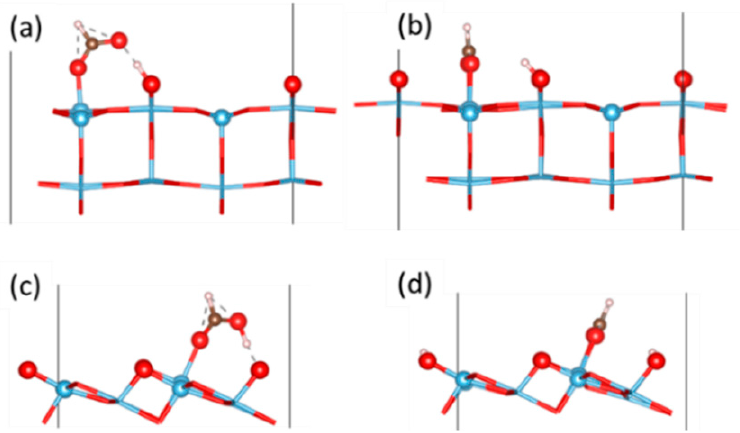
Figure 1. Side views for M and BB species at the rutile (110) surface ( a , b ) and at the anatase (101) surface ( c , d ). Blue: Ti; red: O; brown: C; white: H.